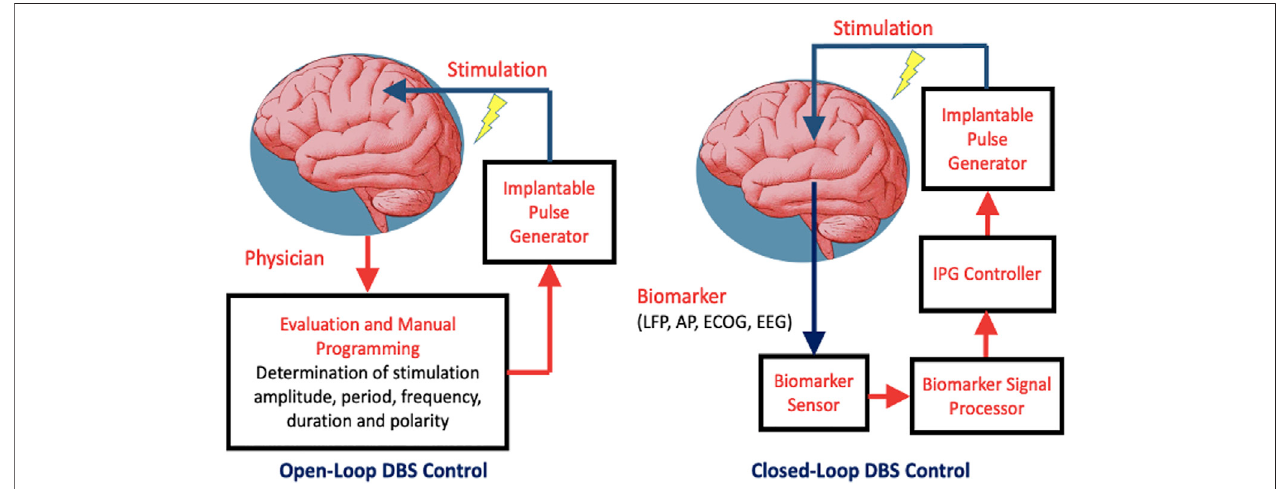
FIGURE3| TwotypesofDBScontrol:open-loopandclosed-loop.Abbreviations:IPG – implantablepulsegenerator;LFP – local fi eldpotential;AP – ActionPotential; ECOG – Electrocorticography; EEG -